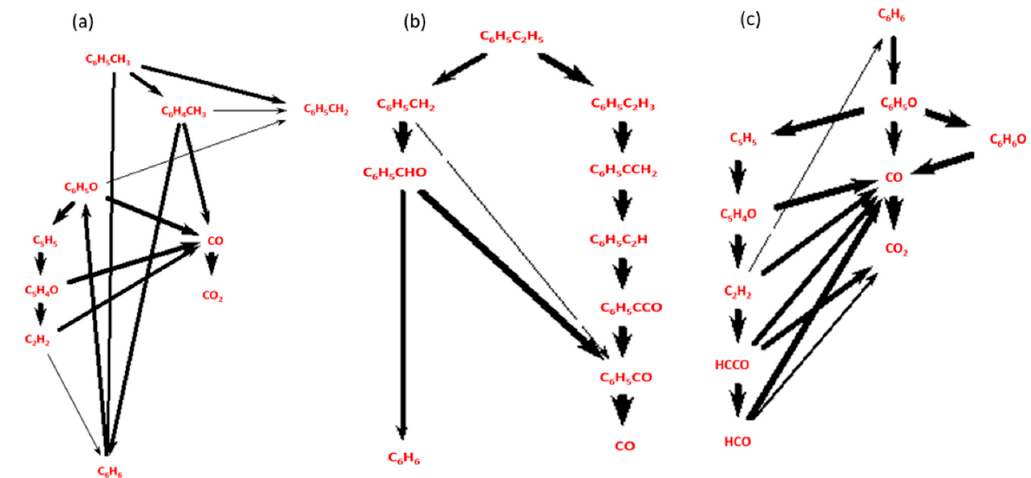
Figure 10. Reaction pathways of C 6 H 5 CH 3 ( a ) and C 6 H 5 C 2 H 5 ( b ) into C 6 H 6 , and that of C 6 H 6 ( c ) into CO 2 .